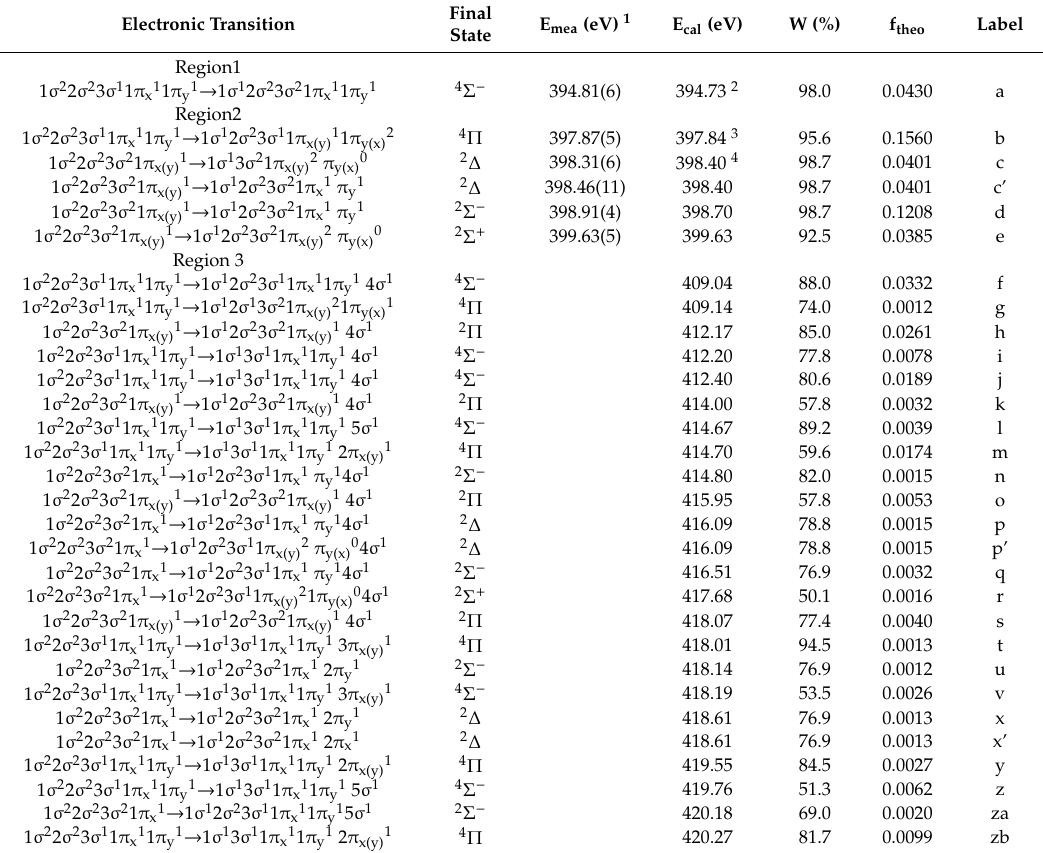
1 The number in brackets is the uncertainty on the last digit. 2 Vertical relativistic density functional theory (DFT) value (394.73 eV) corrected by zero-point energy (0.02 eV) used as reference. 3 Vertical transition energy value at 1.096 Å (Multiconfiguration self-consistent Field (MCSCF) minimum distance of the 4 Σ − ground state) deduced from Figure 2. 4 Doublet vertical transition energy value at 1.065 Å (Multiconfiguration self-consistent Field (MCSCF) local minimum of the 2 Π ground state) deduced from Figure 2. 394.77 eV and 395.14 eV, respectively, in good agreement with experimental